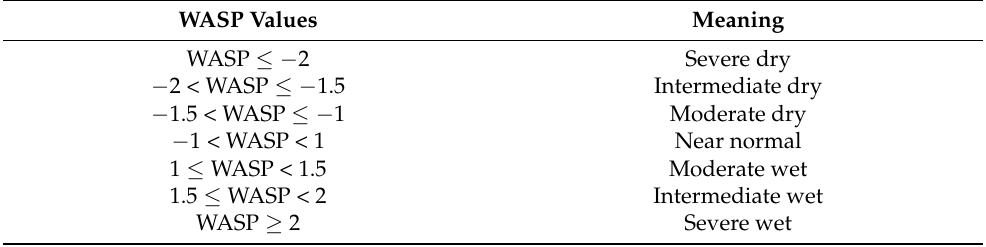
Table 2. WASP-Index values and their corresponding meaning [30,32].